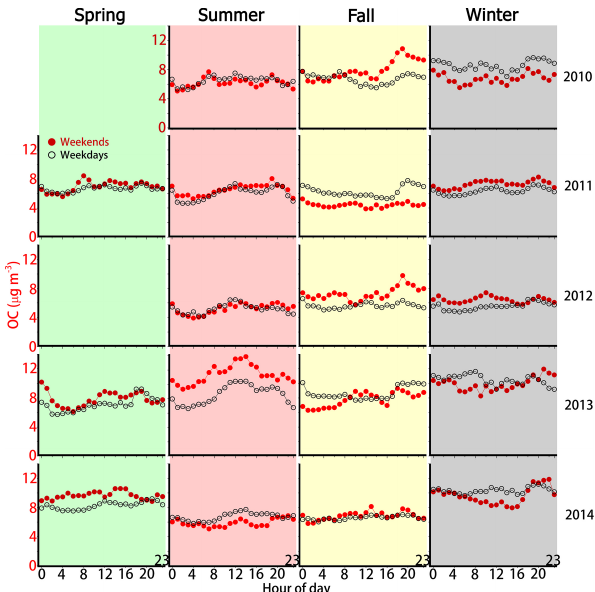
Figure 10. Diurnal variations of OC concentrations during week- days and weekends over different years in